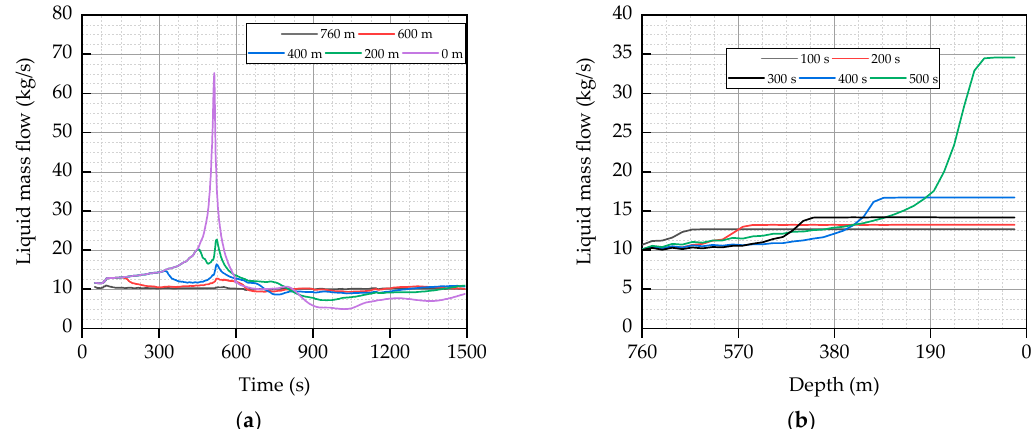
Figure 16. Variation of liquid mass flow at different: ( a ) times; and ( b ) depths.